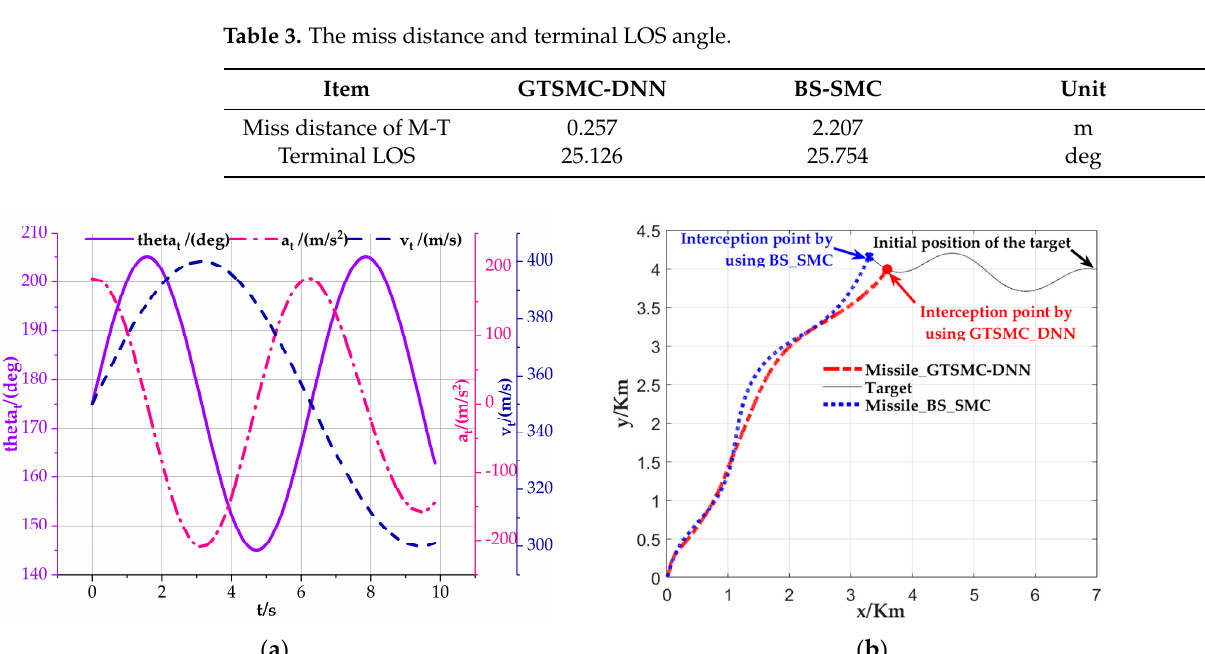
( b ) Figure 11. ( a ) The adaptive weight parameters of DNN; ( b ) System states of m θ angle.